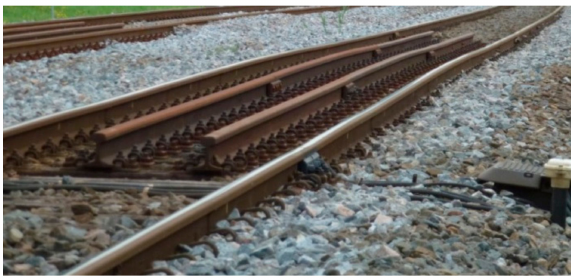
Figure 16. Transition zone with large track